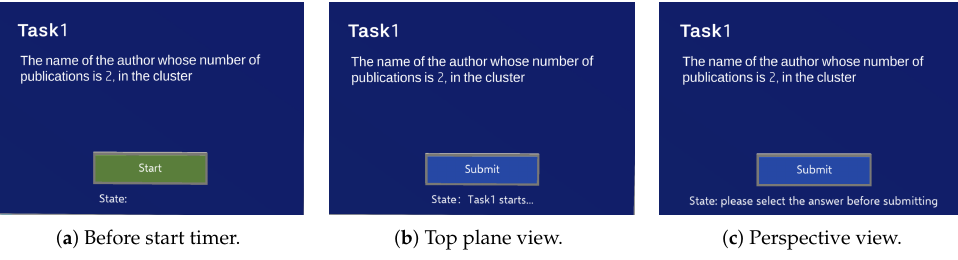
Figure 6. Task panel for timing in